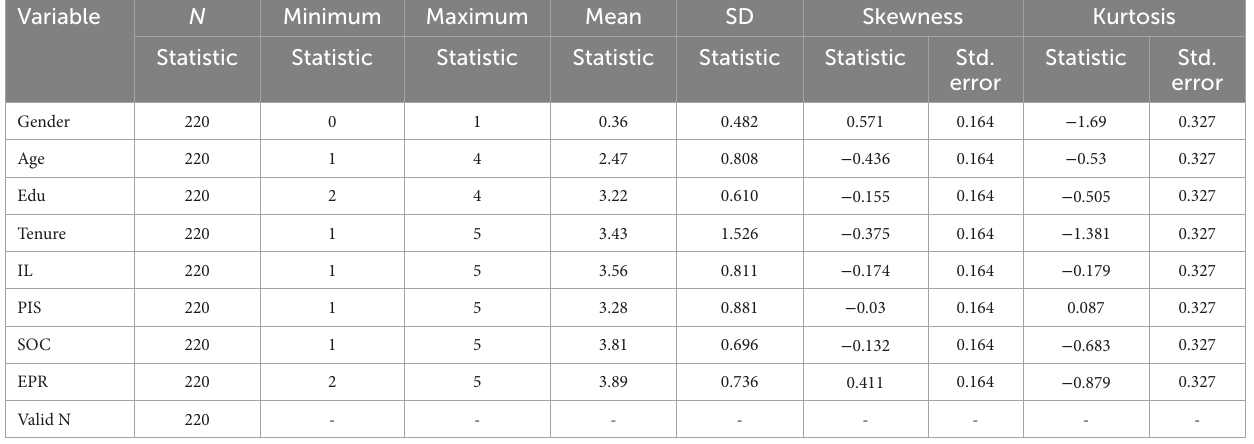
Gender (0 = female, 1 = male); N = 220. TABLE 2 Correlations for the study